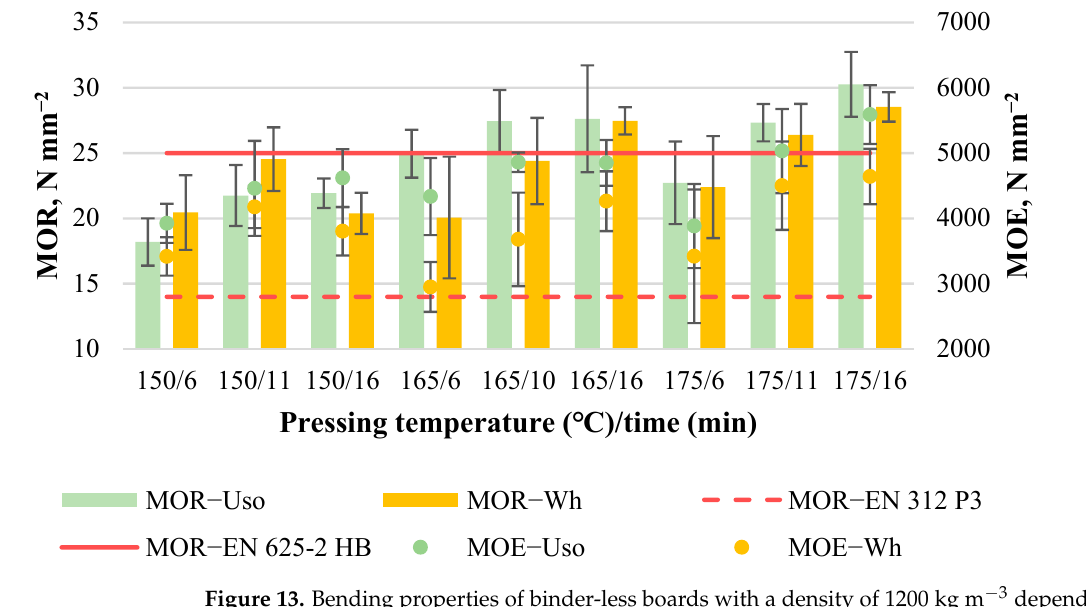
Figure 13. Bending properties of binder-less boards with a density of 1200 kg m − 3 depending on the crop and pressing variables.